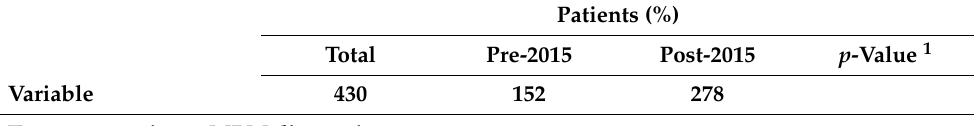
Table 2. Treatment patterns before and directly after diagnosis of melanoma brain metastasis